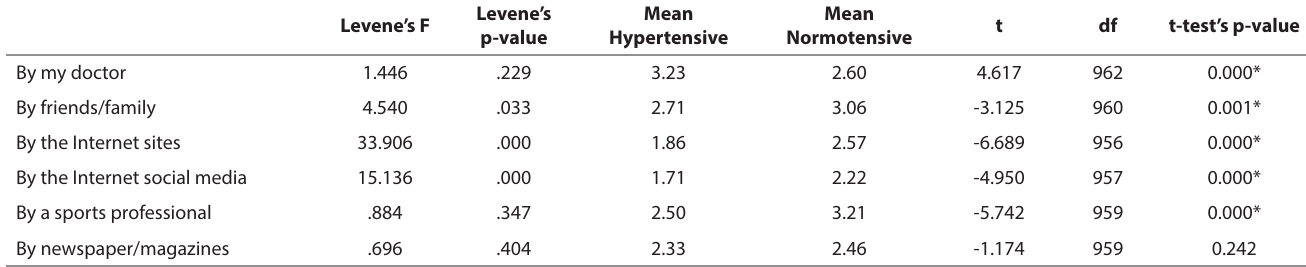
TABLE 3. Information seeking about physical